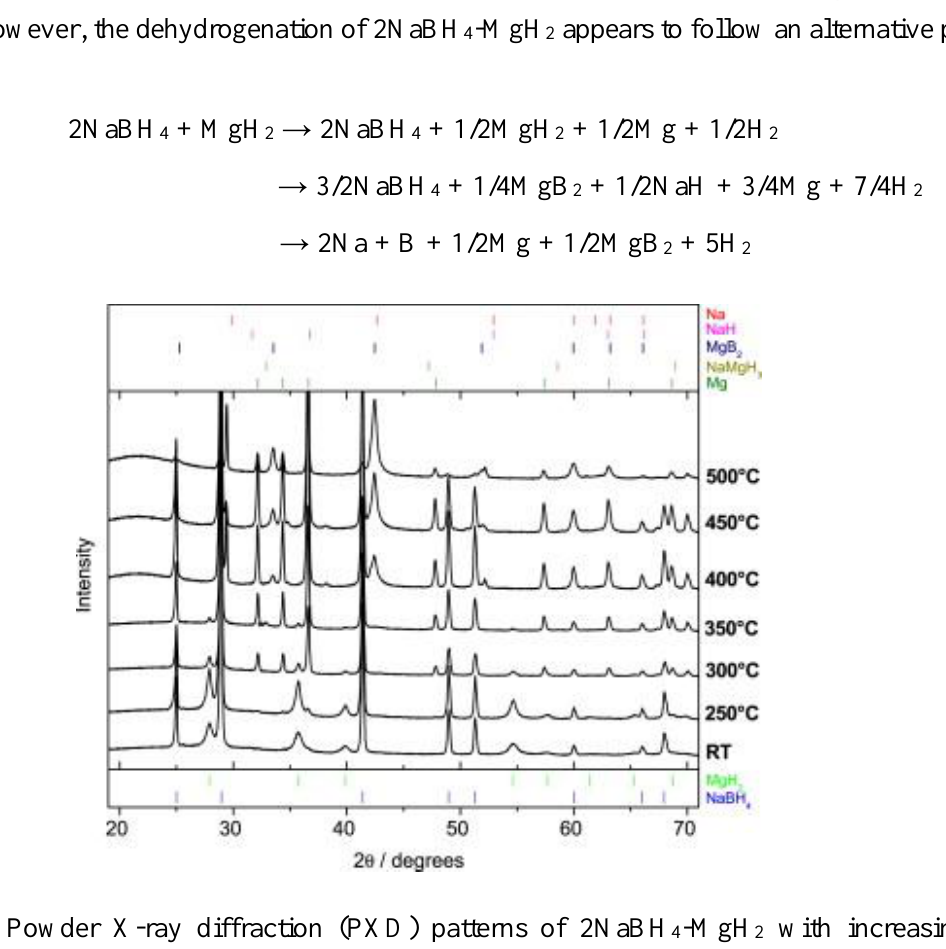
Figure 5. Powder X-ray diffraction (PXD) patterns of 2NaBH 4 -MgH 2 with increasing temperature [48]. Reprinted from [48] with permission from the International Association of Hydrogen